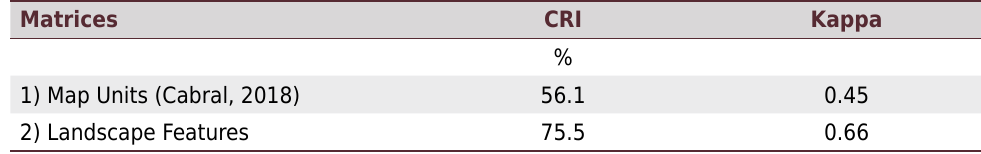
Table 3. Results of data matrices processing for